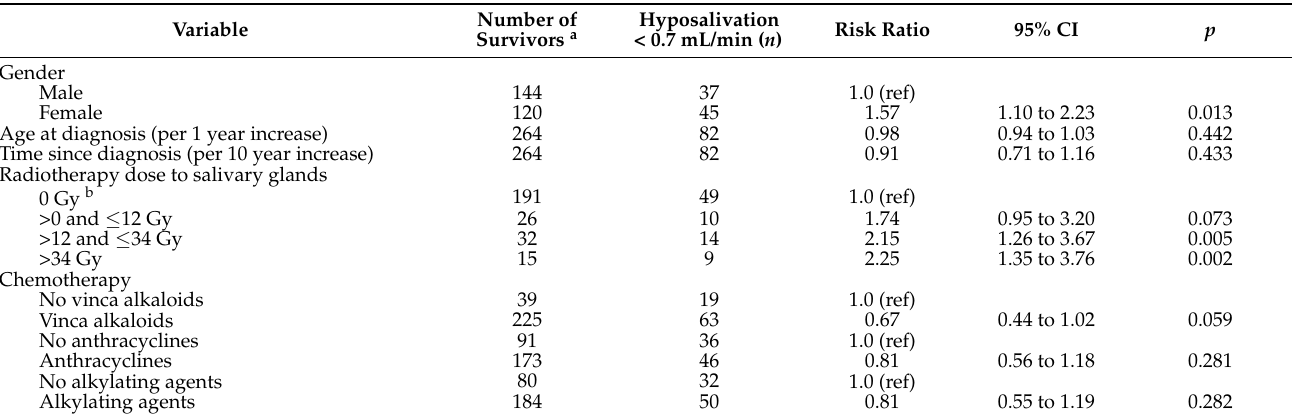
Table 6. Poisson regression analysis for hyposalivation, measured by stimulated whole salivary flow rates in childhood cancer survivors ( n =